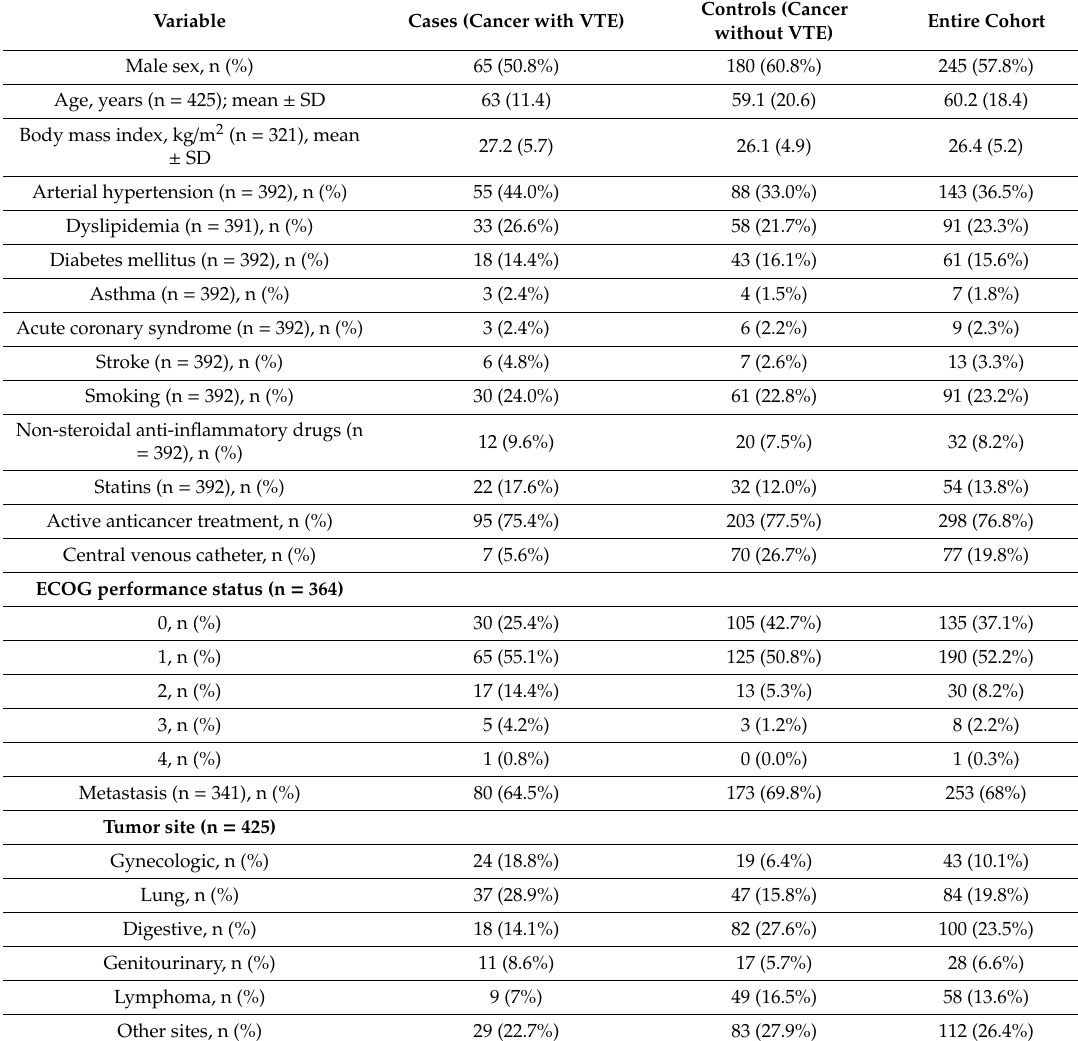
Table 1. Clinical characteristics of the study